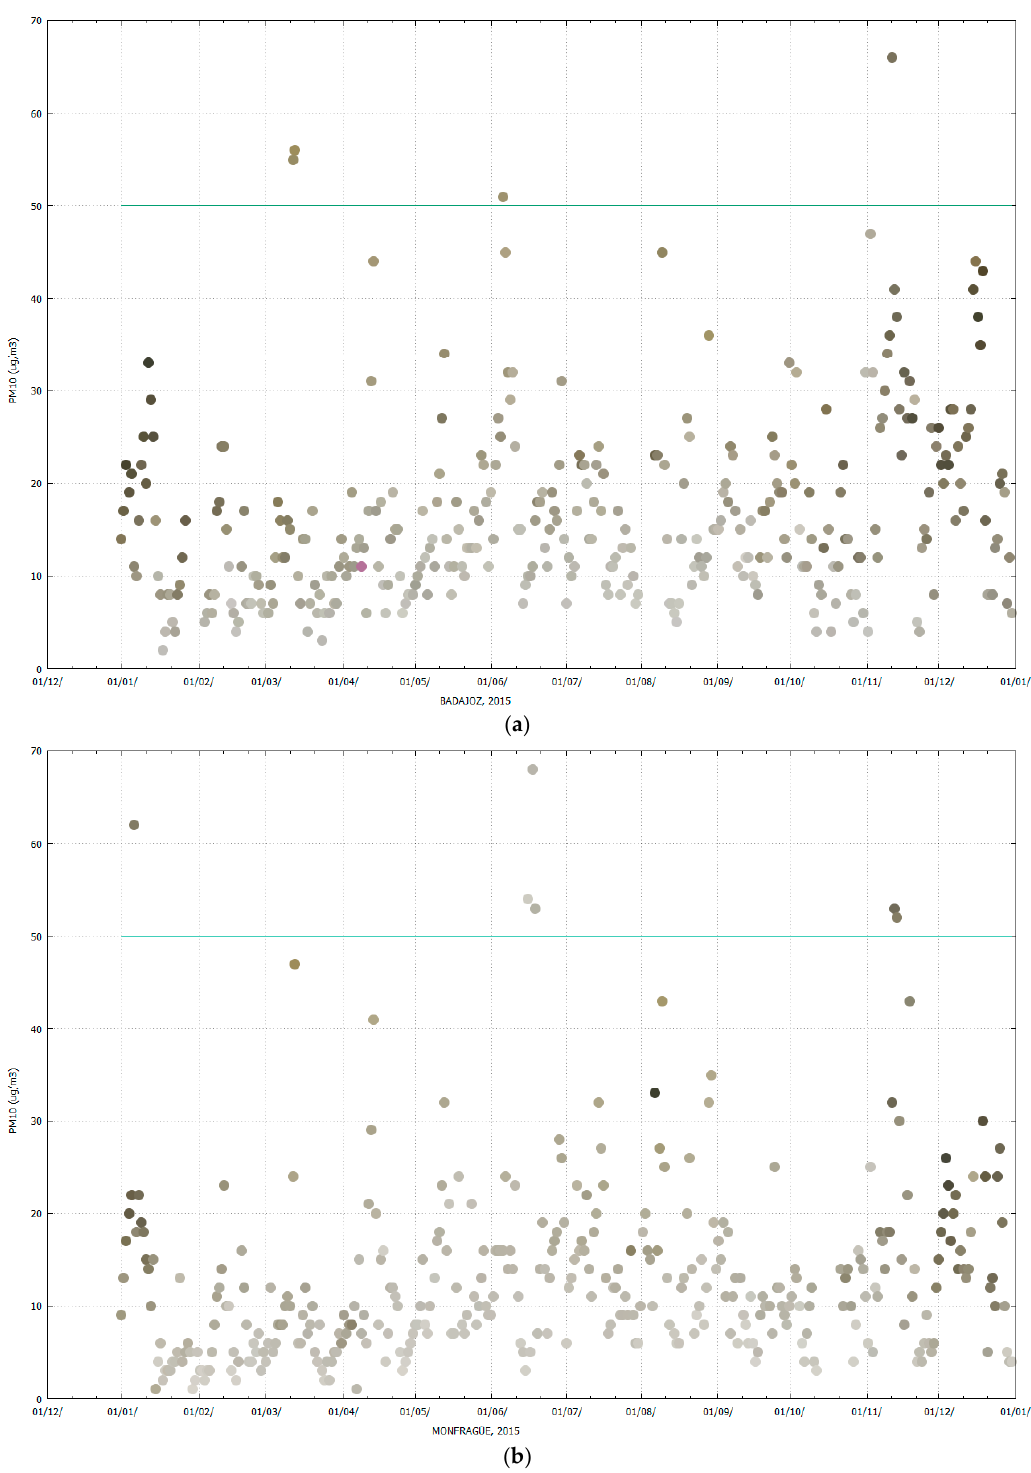
Figure 5. Evolution of PM 10 concentration during 2015 ( a ) Badajoz (BA); ( b ) Monfragüe (MF). The colour of each sample dot corresponds to its RGB value. The green line represents the legal daily limit value of PM 10 concentration for the protection of human health according to Directive 2008/50/EC (50 µg/m 3 ).